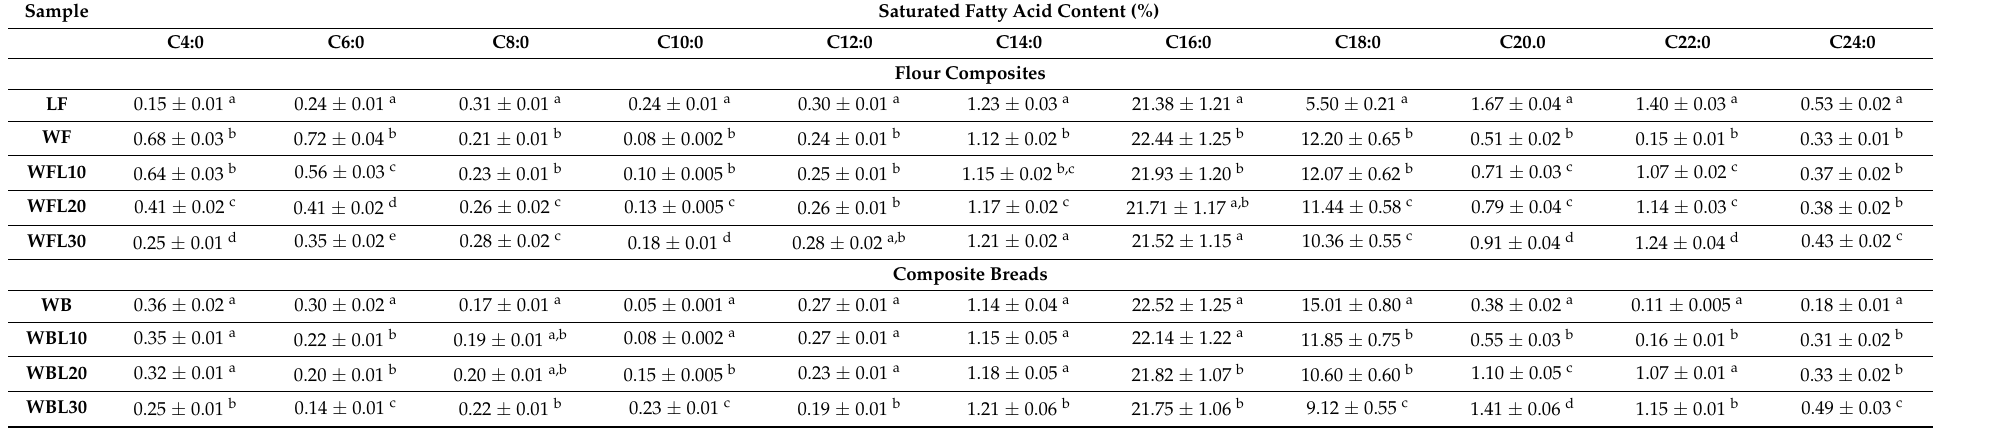
Table 5. Saturated fatty acid (SFA) composition of sample expressed as % of total fatty acids.